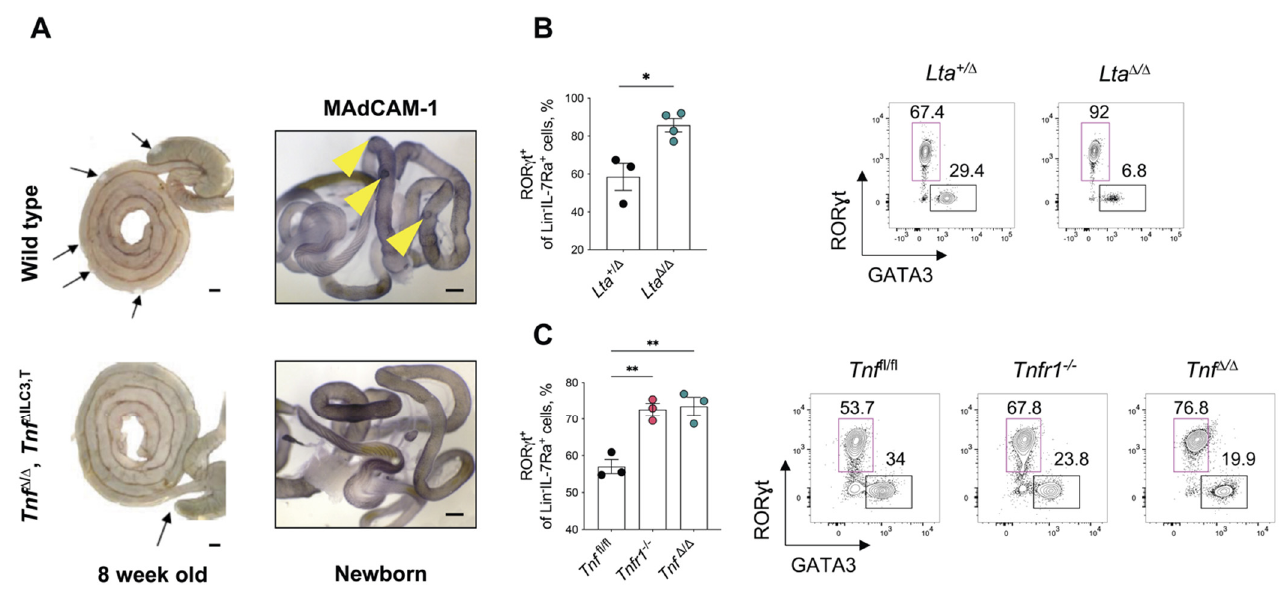
Figure 3. LT α and TNF regulate ILC3 frequency in lamina propria in an adult organism. ( A ) Pho- tographs of mouse intestine, from representative animals, showing the absence of Peyer’s patches and the presence of a cecal patch ( left ) and immunohistochemical staining of intestine from newborn mice ( right ). Arrows indicate Peyer’s patches ( left ) and areas of specific MAdCAM-1 staining ( right ), Scale bars, 4 mm; ( B , C ) Frequency of ROR γ t + ILC3 cells and representative FACS plots of ROR γ t + and GATA3 + cells among Lin − IL-7R α + cells gated on live CD45 + cells isolated from the lamina propria ( right ). Each symbol represents an individual mouse; mean ± SEM. * p < 0.05 (two-tailed